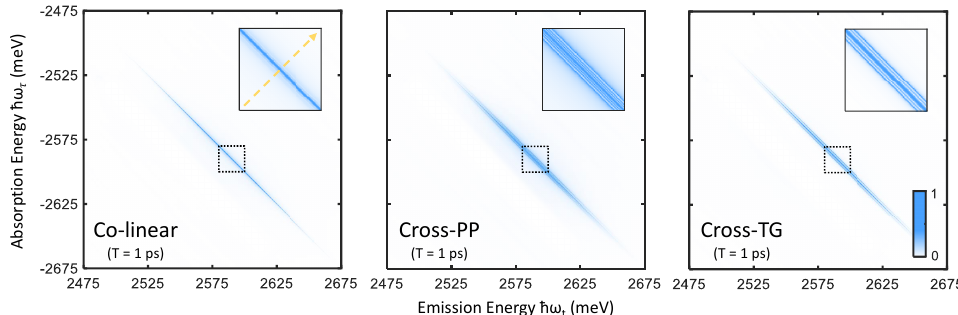
Figure 4. Rephasing one-quantum spectra simulated for colinear ( left ), cross-PP ( middle ), and cross- TG ( right ) excitation and T = 1 ps. The sections of the spectra outlined by the dashed boxes are plotted inset, which show the appearance of sidebands with cross-PP and cross-TG excitation. The yellow dashed arrow in the left inset plot indicates the position and direction of the cross-diagonal slices shown in Figure 5.